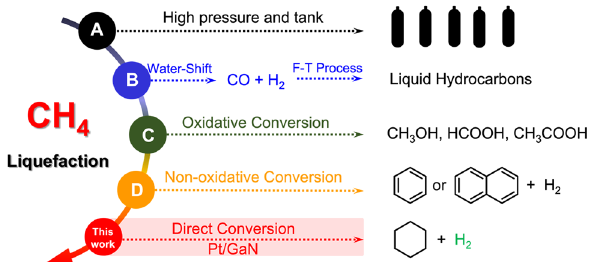
Figure 1. Methods for methane liquefaction. ( a ) High pressure tank for methane storage. ( b ) Typical two-steps process in large-scale industrial catalysis. ( c ) Oxidative conversion of methane into primary fuels and ( d )